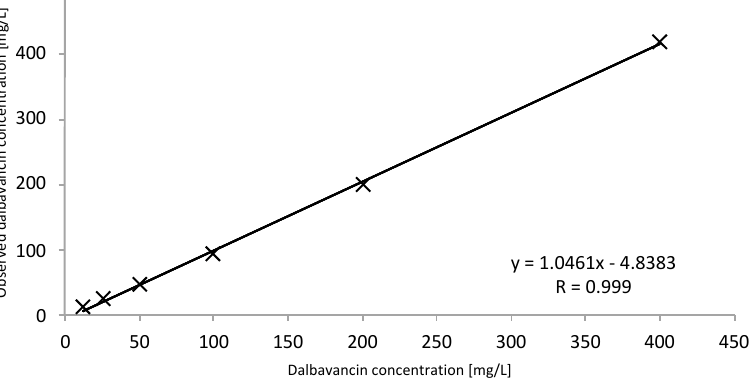
y = 1.0461x - 4.8383 R = 0.999 0 Figure 2. Calibration curve to determine total dalbavancin. A calibration curve was performed with serum calibration standards at 12.5, 25, 50, 100, 200, and 400 mg/L concentrations (R = 0.999). Table 1. Dalbavancin concentrations of three cardiologic patients.